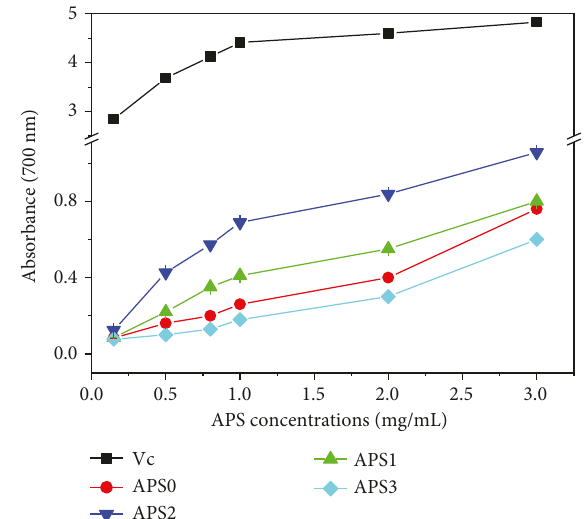
Figure 4: Hydroxyl radical scavenging capacity of APS with di ff erent molecular weights.